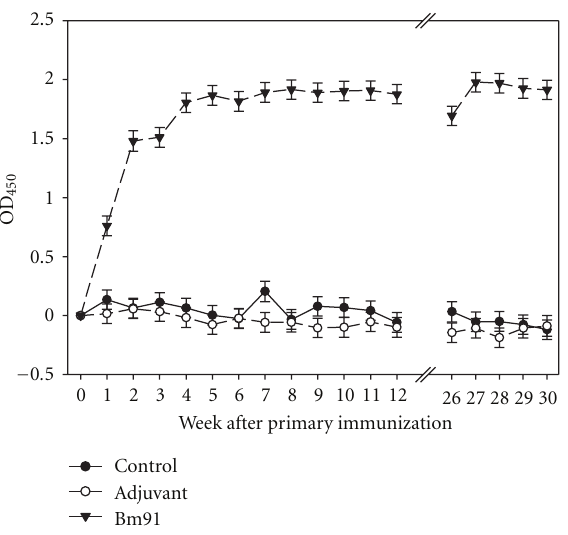
Figure 1: Antibody responses of Bos indicus cattle immunized with the antigen Bm91 and injected with saline (control) and adjuvant, respectively. Values were measured by ELISA and are expressed as optical density 450 (OD 450 ) value (LSM ± S.E.; N = 6). Values were adjusted to week 0. Immunizations were given in week 0, 3, 6, and 26.